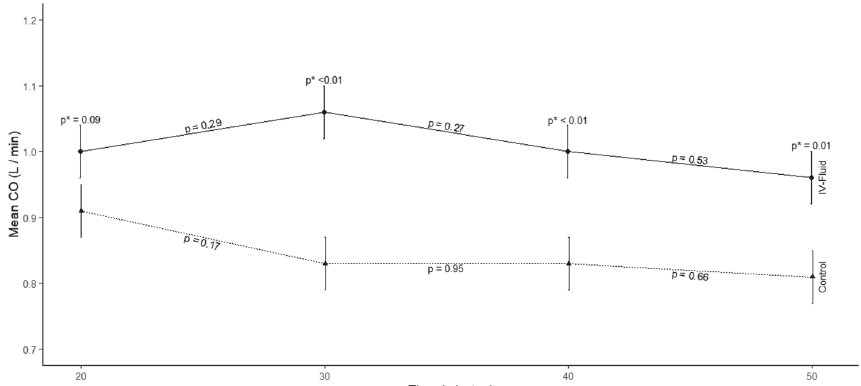
Fig. 2 Mean values standard error of cardiac output for control and IVF groups as a function of time. As ± shown, p values demonstrate differences as a function of group and time after adjustment for baseline differences